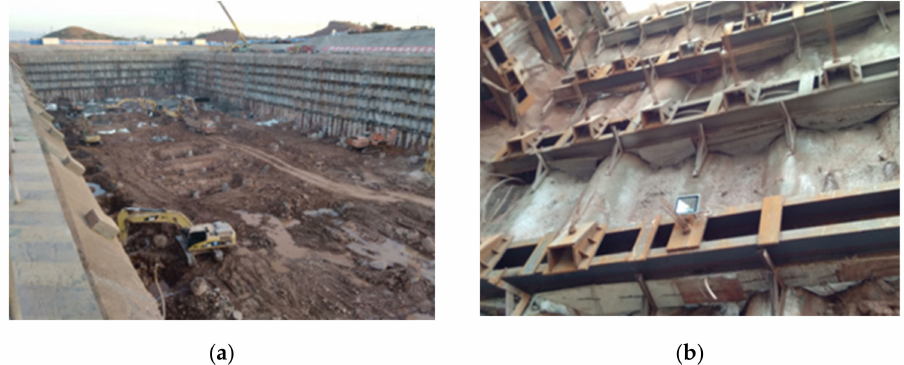
Figure 2. Construction site pictures: ( a ) excavation of foundation pit, ( b ) anchor cable and waist beam. Table 2. Construction